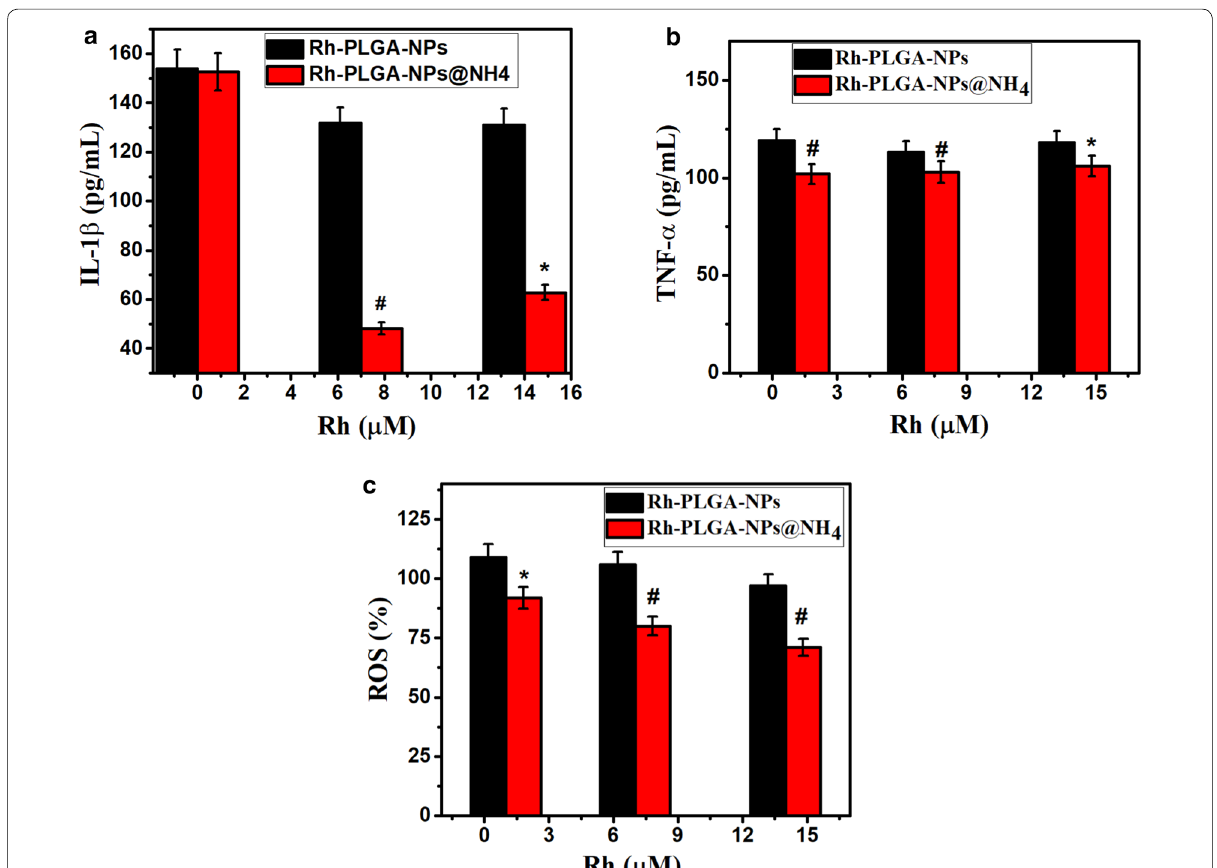
Fig. 6 PLGA-NPs and Rh-PLGA-NPs@NH 4 effect on a IL-1β (*p < 0.01; Rh-PLGA-NPs@NH 4 vs. Rh-PLGA-NPs, #p < 0.001; Rh-PLGA-NPs@NH 4 vs. Rh-PLGA-NPs). b TNFα (*p < 0.05; Rh-PLGA-NPs@NH 4 vs. Rh-PLGA-NPs, #p < 0.05; Rh-PLGA-NPs@NH 4 vs. Rh-PLGA-NPs) and c ROS levels (*p < 0.05; Rh-PLGA-NPs@NH 4 vs. Rh-PLGA-NPs, #p < 0.01; Rh-PLGA-NPs@NH 4 vs. Rh-PLGA-NPs). Data represent the mean